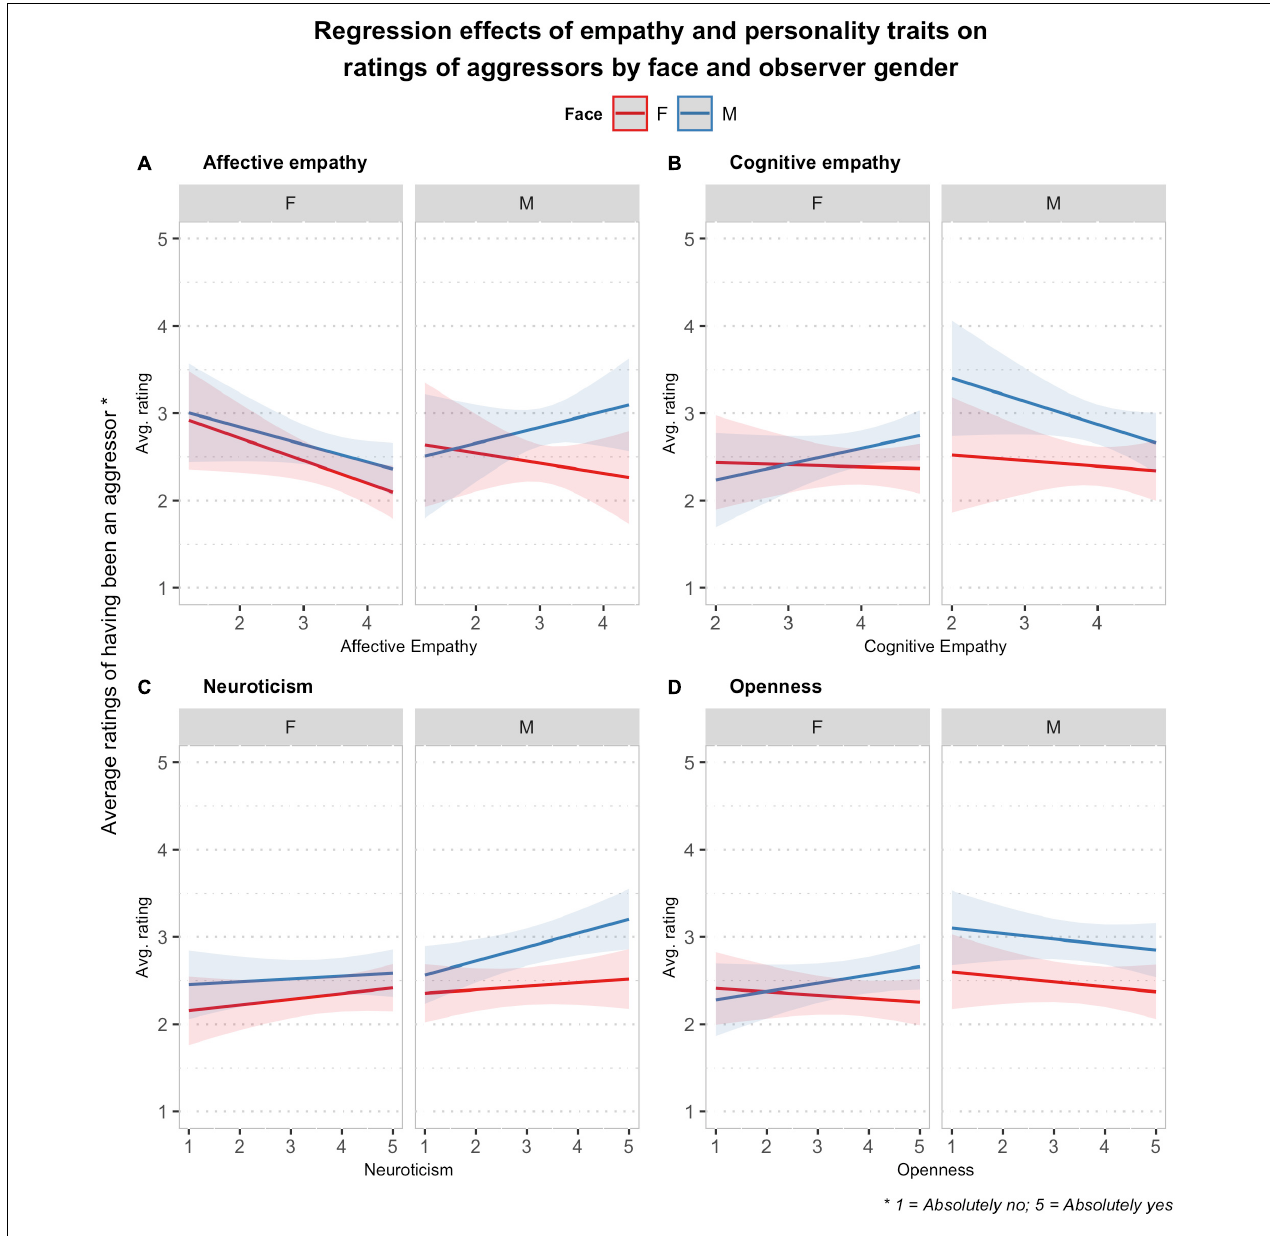
FIGURE 4 | Plots of the three-way interaction effects (i.e., regression slopes) estimated from the linear mixed-effects models including empathy (A) affective, (B) cognitive and personality variables (C) neuroticism, (D) openness to experience as predictors of the ratings about the history of aggression for the persons represented in the